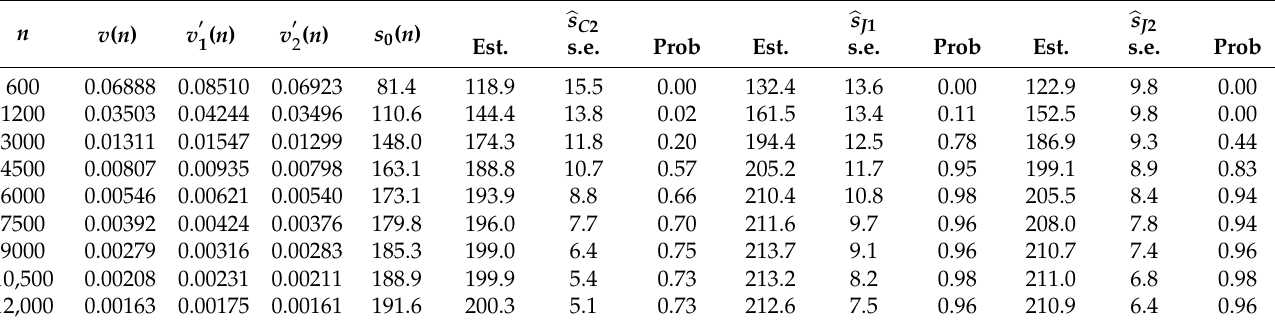
Table 5. Barro Colorado Island’s Forest Data (Numbers of species in two populations are s 1 = 308 & s 2 = 207 and the number of shared species is s 0 = 207; J 1 & J 2: 1st & 2nd Jackknife estimates, C 2: Chao’s estimate, s 0 ( n ): number of observed shared